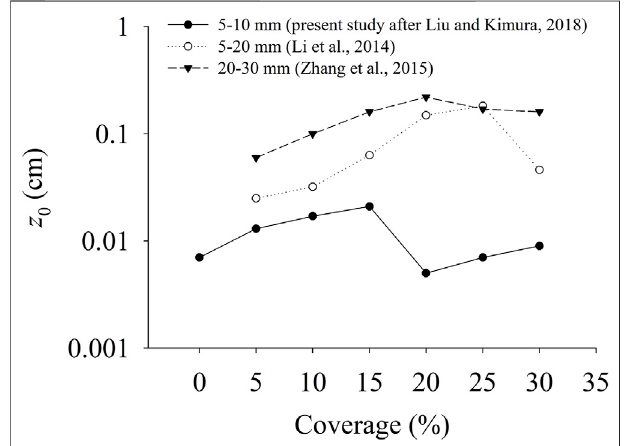
FIGURE 6 | Comparison of average roughness length z 0 at different gravelcoveragesfromLiuandKimura(2018)withotherpublisheddatafromLi et al. (2014) and Zhang et al.